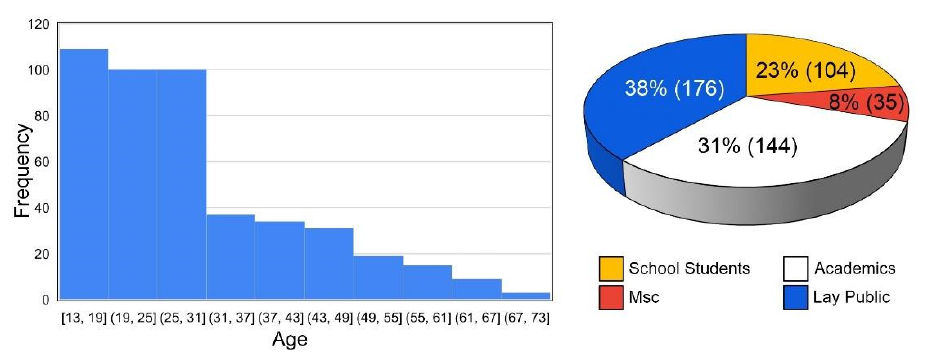
Figure 6. Graphs showing the results related to the General questions provided to the participants after their experience. To the left, relative frequency histogram displaying the age of the participants, grouped each 6 years, and, to the right, Pie chart showing the frequency of each category.